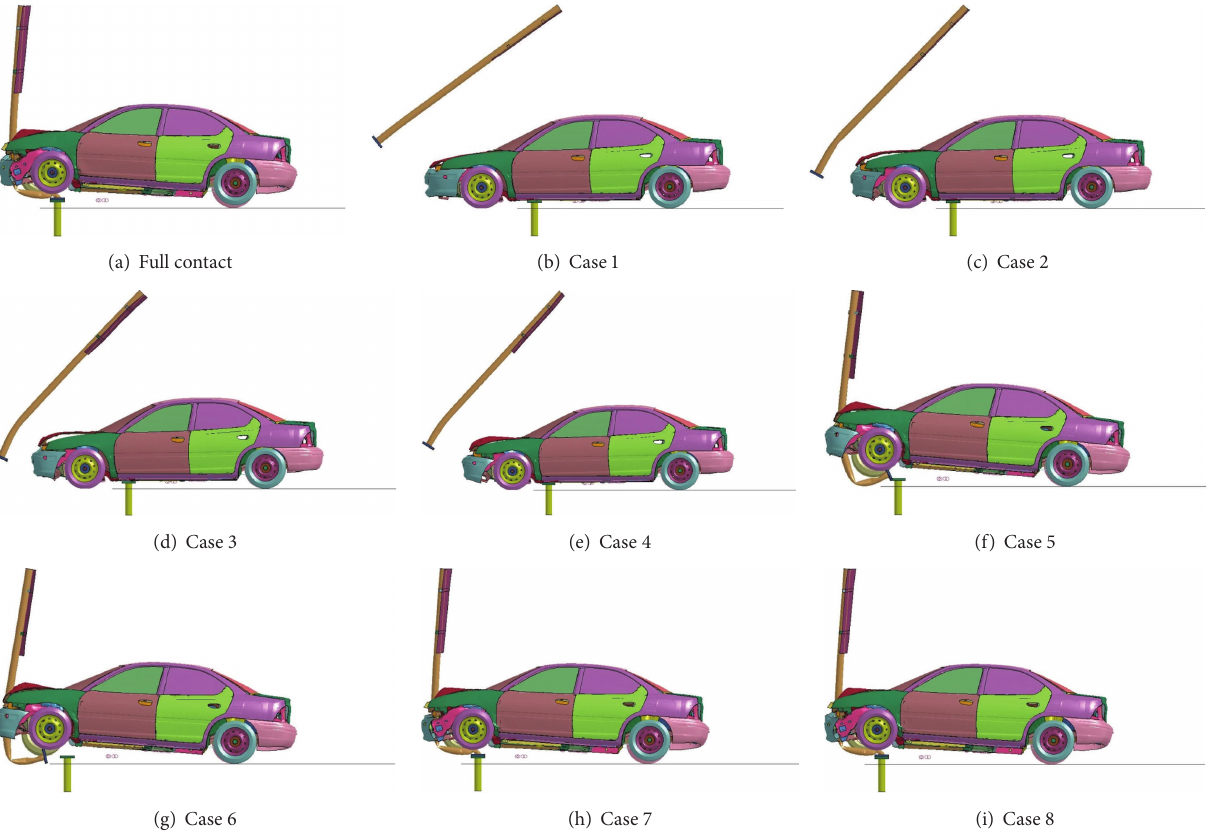
Figure 14: Deformed shapes for different cases